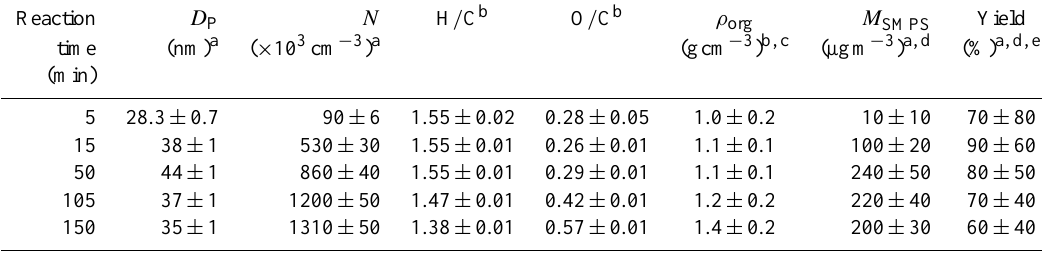
Values are the average of a three consecutive SMPS measurements, and b five consecutive O / C and H / C AMS measurements, and uncertainties represent the corresponding standard deviation of these averages.